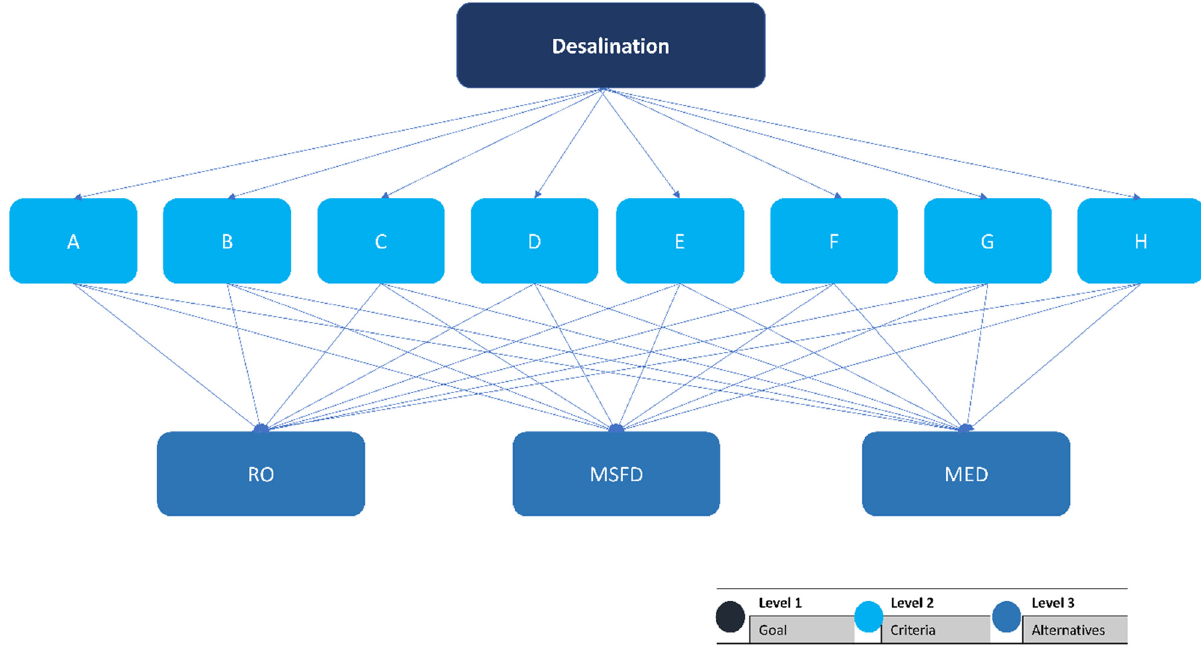
Figure 4: Analytical hierarchy for comparison of the desalination technologies.